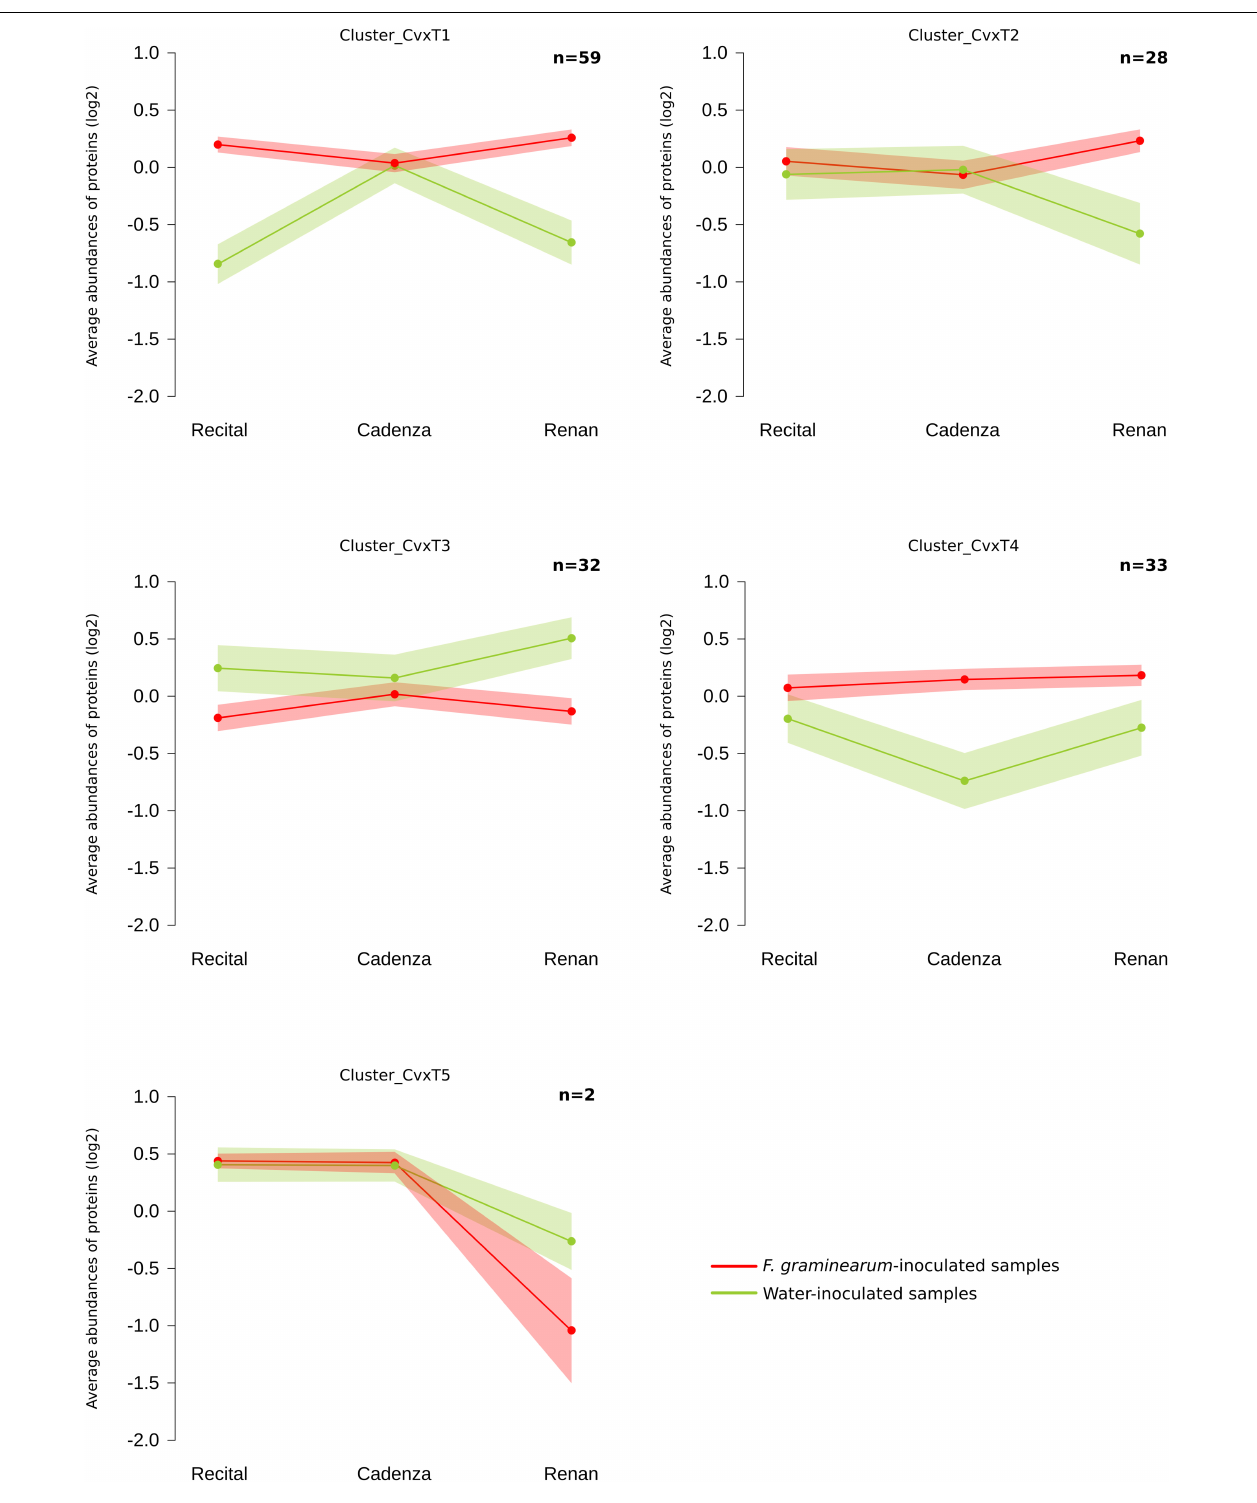
FIGURE 5 | Clustering of wheat Cultivar × Treatment_effect protein abundance patterns. Clustering was computed using the fuzzy C-means method from Z -score transformed values to identify homogeneous patterns. For the five clusters, the average profile was represented by the line plot with the wheat cultivars on the x -axis and the normalized abundances on the y -axis. A color code was given for the two treatment modalities: red : average protein abundances observed in Fusarium graminearum -inoculated samples; green : average protein abundances observed in the water-inoculated samples. The number of proteins in each cluster is indicated in the upper right-hand corner of the graphs ( n ). Ribbons indicate the 95% confidence interval and retain the same color code.